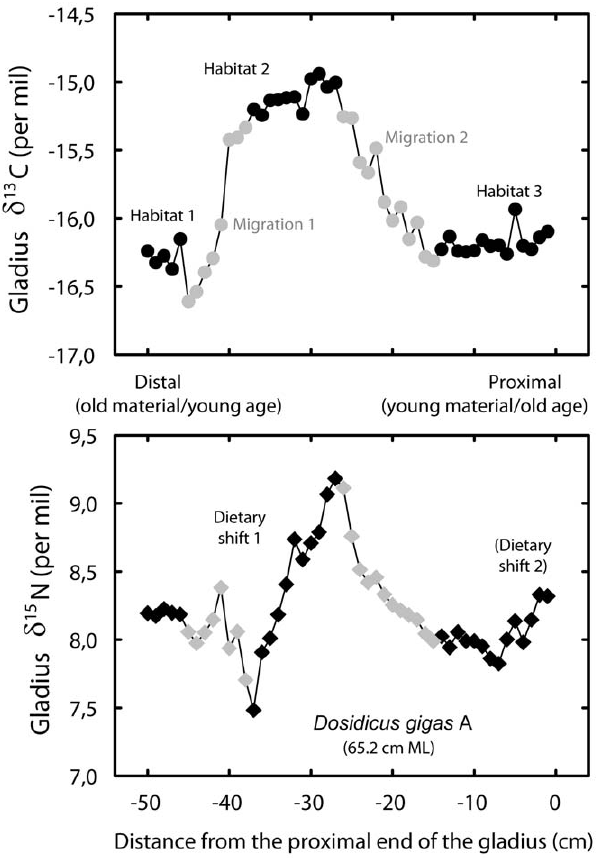
Figure 2. High resolution isotopic profile along individual A gladius. d 13 C (filled circles) and d 15 N (filled diamonds) values along the length of the gladius of a 65.2 cm ML jumbo squid. Grey symbols represent periods of migration, while black symbols illustrate a more fixed isotopic habitat.